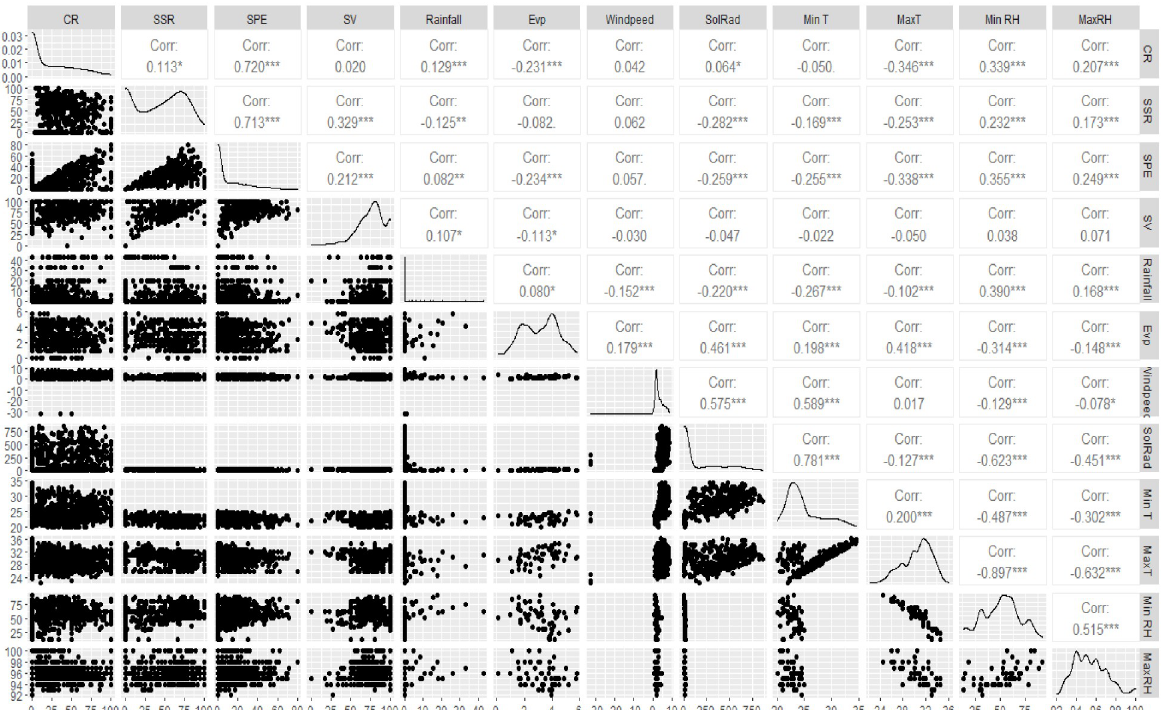
Fig 8. Relationships among yam pollination traits and weather parameters. CR = crossability rate/pollination success, SSR = seed set rate, SPE = seed production efficiency, SV = seed viability, Evp = evaporation, windpeed = wind speed, SolRad = solar radiation, Min T = minimum temperature, MaxT = maximum temperature, Min RH = minimum relative humidity, MaxRH = maximum relative